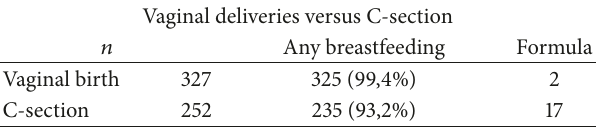
Figure 1: Linear regression of the three groups. M: SSC mother; F: SSC father; NM NF: no SSC. Table 3: Percentage feeding type at